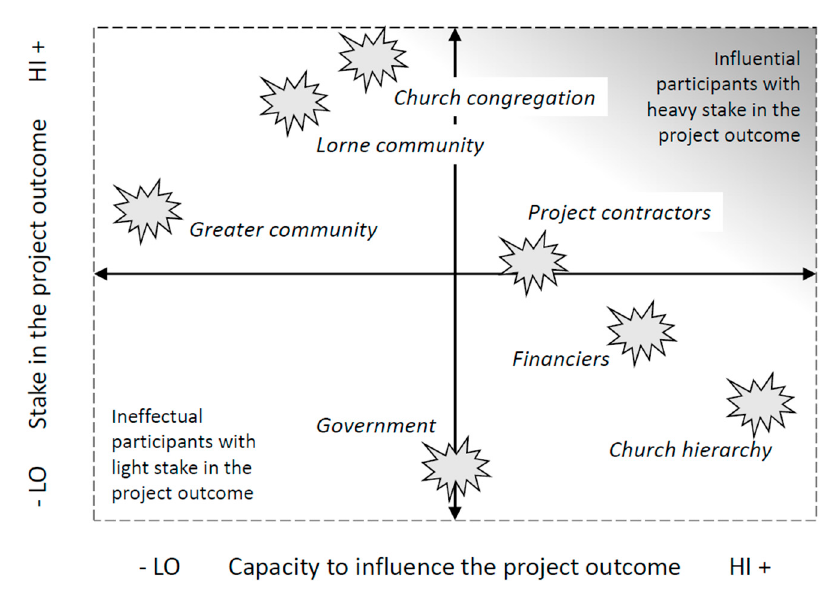
Figure 8. Degree of impact of the project on various stakeholders, plotted against their capacity to influence the project outcome.